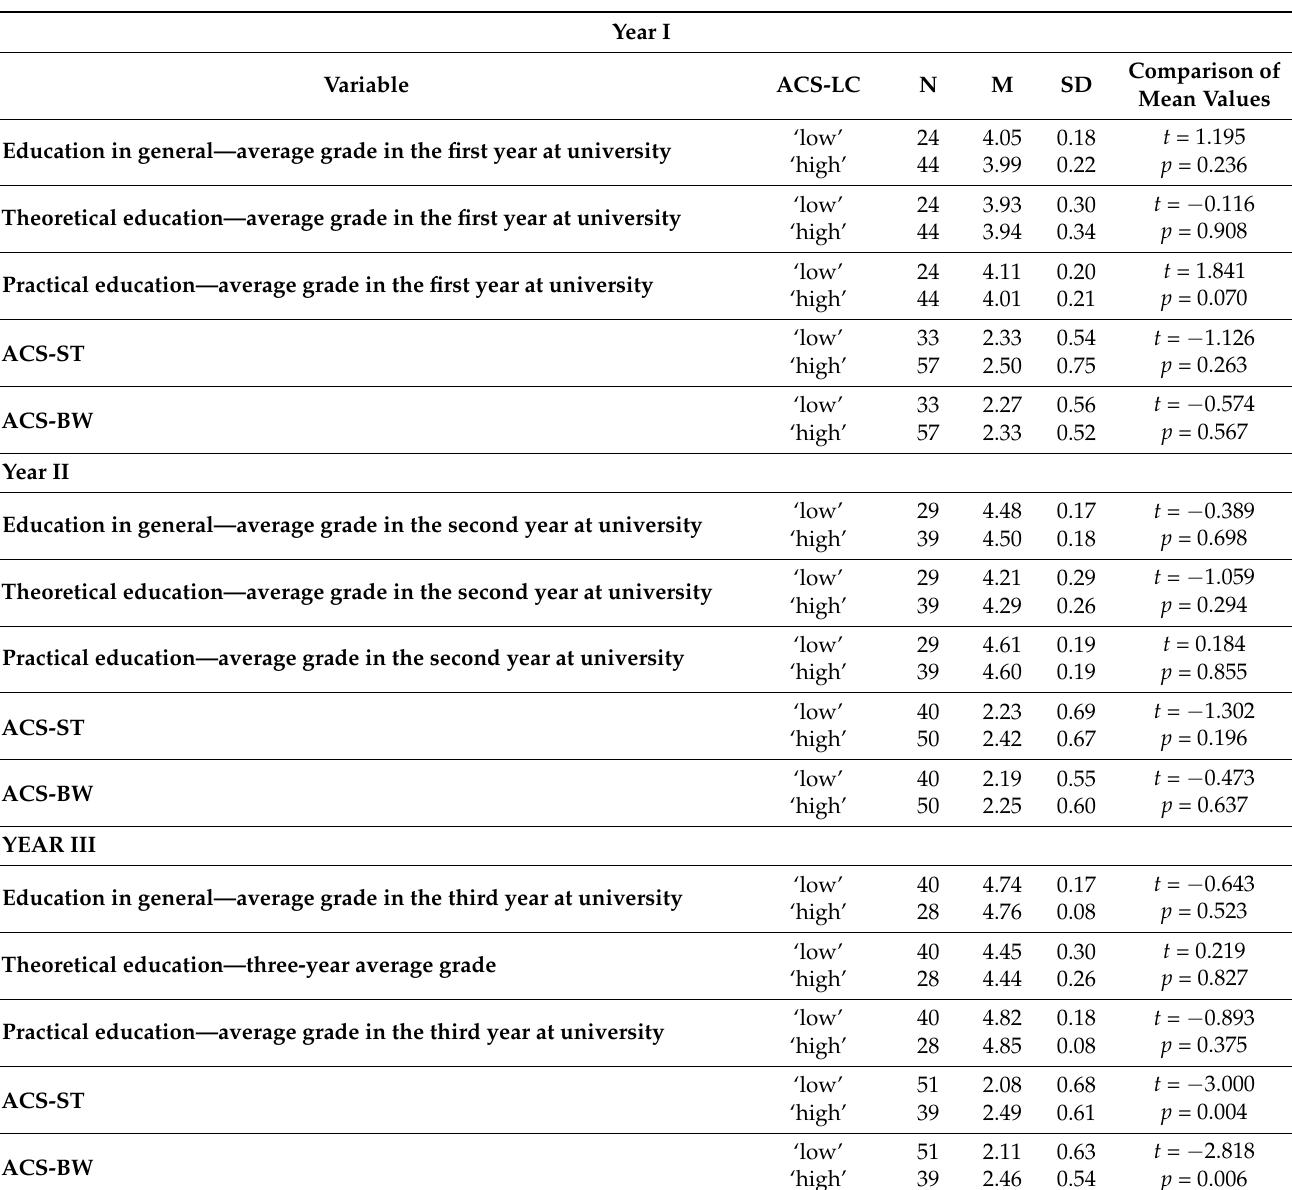
Table 5. Comparison of results of theoretical and practical education, student–teacher relationship (ACS-ST), student’s belonging to the group (ACS-BW) between respondents with lower and higher nursing competences, based on data collected after the first, second, third year at university. Year I Comparison of Variable ACS-LC N M SD Mean